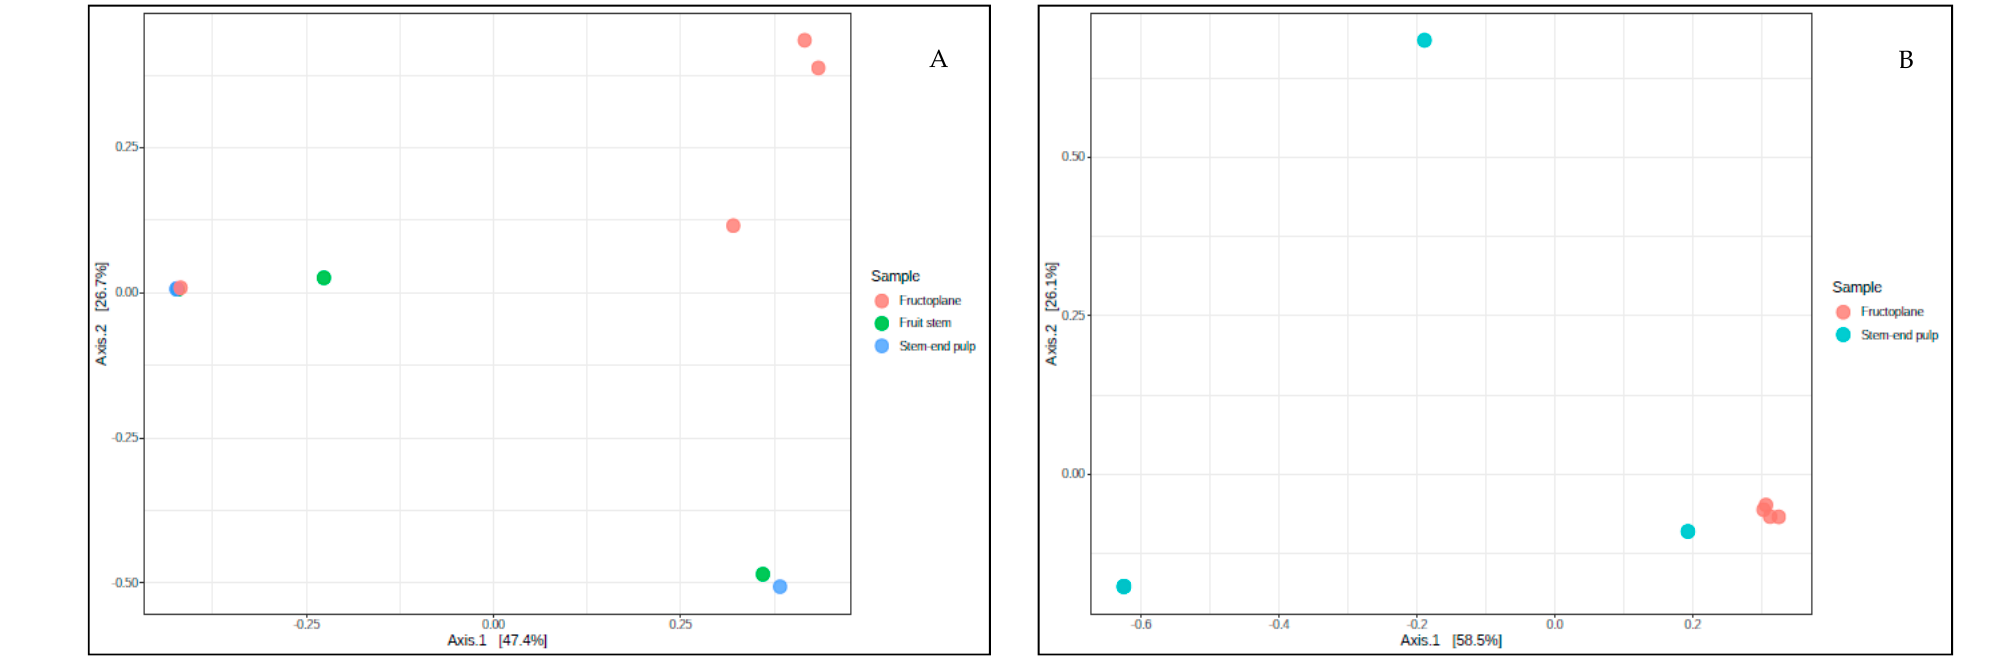
Figure 1. Principal component analysis of the mango fructoplane and stem-end pulp fungal community compositions at the ( A ) pre-harvest and ( B ) post-harvest stages of cv. Tommy Atkins mangoes, according to Illumina sequencing data.